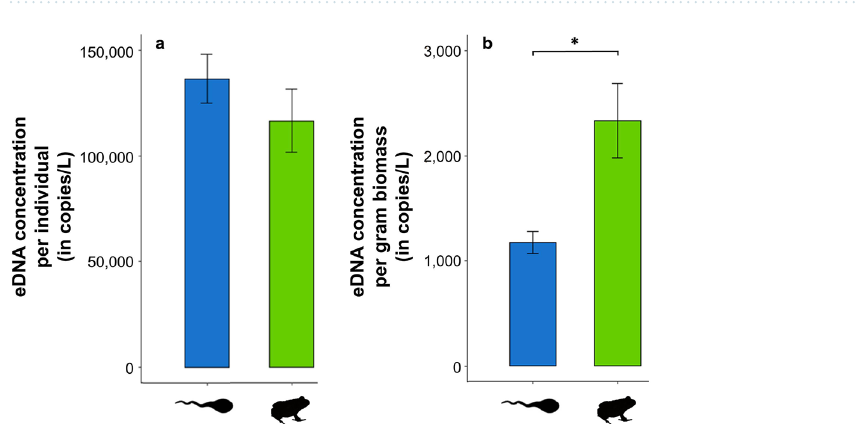
Figure 5. Average (± 1 s.e.m.) per individual ( a ) and per gram biomass ( b ) eDNA concentration of bullfrog tadpoles (blue) and juveniles (green) calculated across mesocosms and expressed as copies per liter filtered